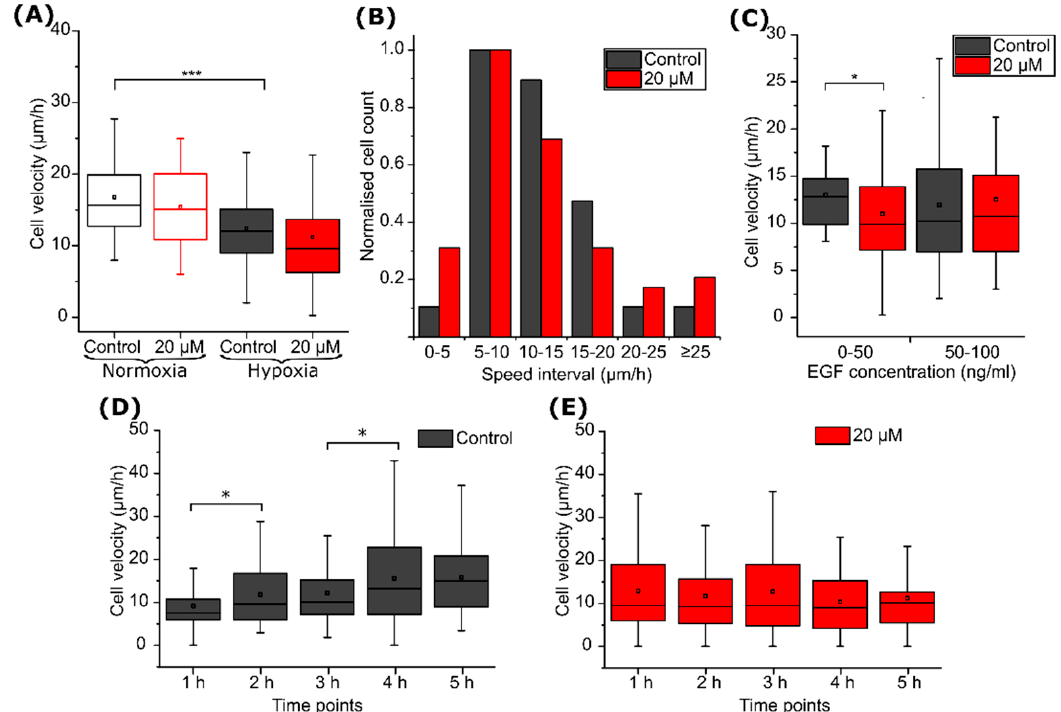
Figure 7. MDA-MB-231 cell migration in the microfluidic device. Velocities of MDA-MB-231 cells ( A ) under normoxia or hypoxia and in the presence or absence of 20 µM VD11-4-2; the amount of the cells migrating in different speed ranges under hypoxia conditions ( B ), starting EGF concentration influence on cell velocities (n = 30, 49, 31, 27), ( C ) and velocity changes during the time of control ( D ) and compound treated ( E ) cells (* p < 0.05; *** p < 0.001).